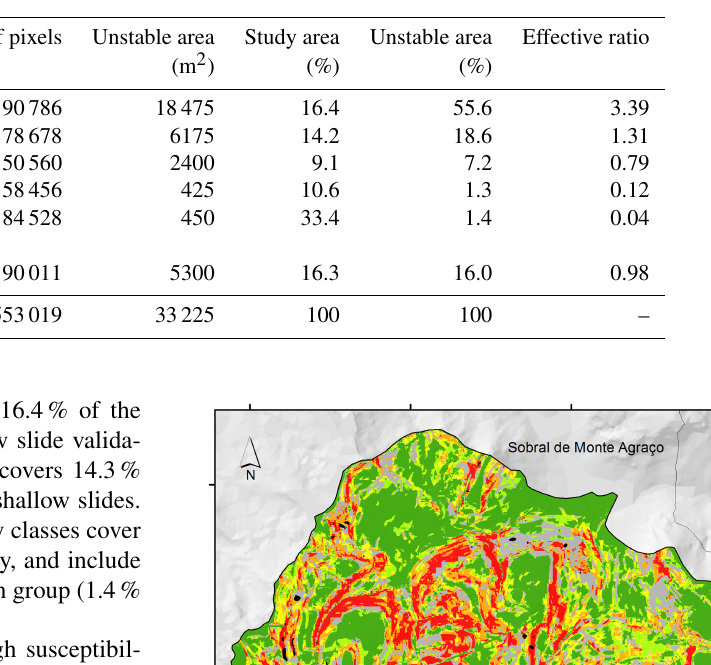
Table 8. Susceptibility classes and corresponding effective ratios of the final shallow slide susceptibility map.